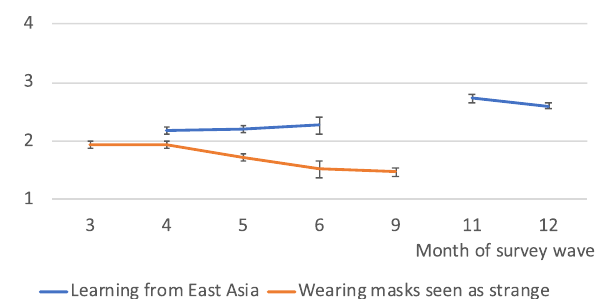
Fig. 1 Agreement to the statements that wearing a mask is strange, and that we can learn a lot from East Asia about how to handle epidemics.